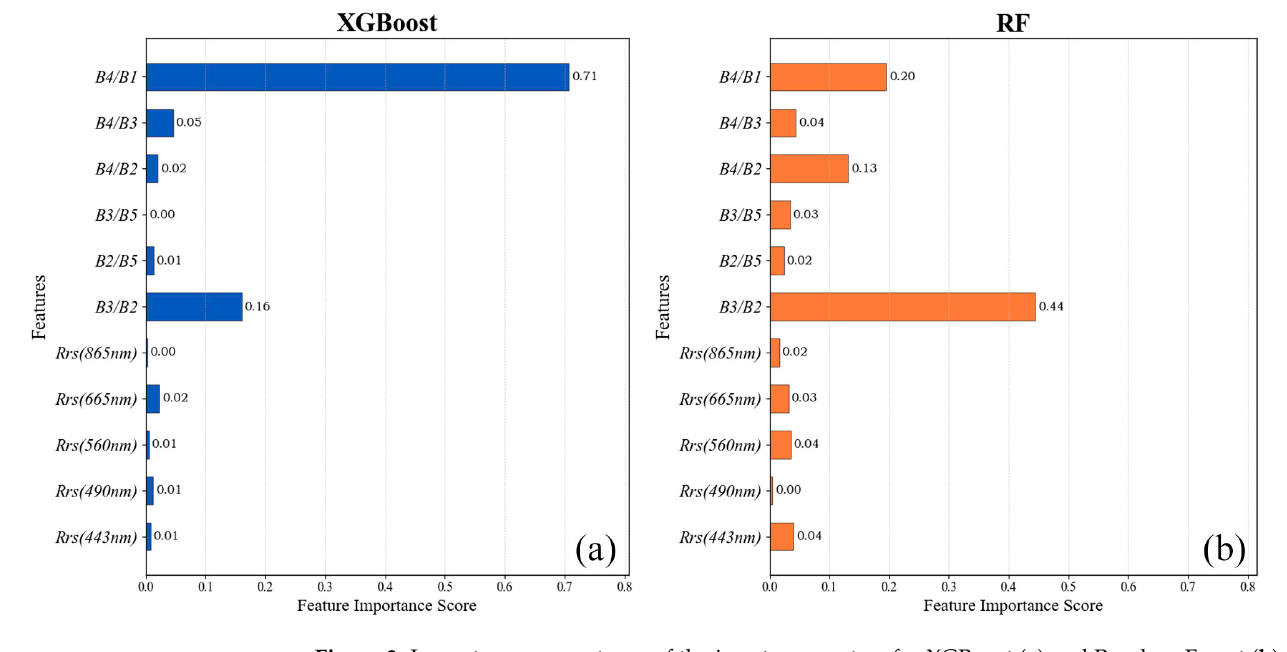
Figure 3. Importance percentages of the input parameters for XGBoost ( a ) and Random Forest ( b ).